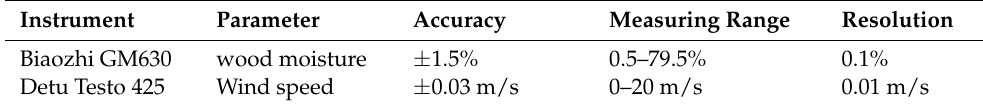
Table 1. Monitoring instrument